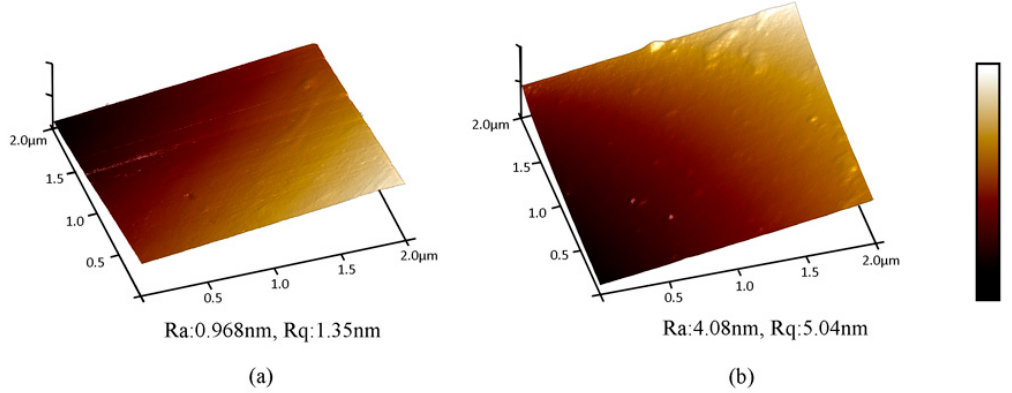
Figure 7. AFM images of oak after coating at di ff erent coating amount. ( a ) 12 g / m 2 PUA coated oak; ( b ) 60 g / m 2 PUA coated oak.